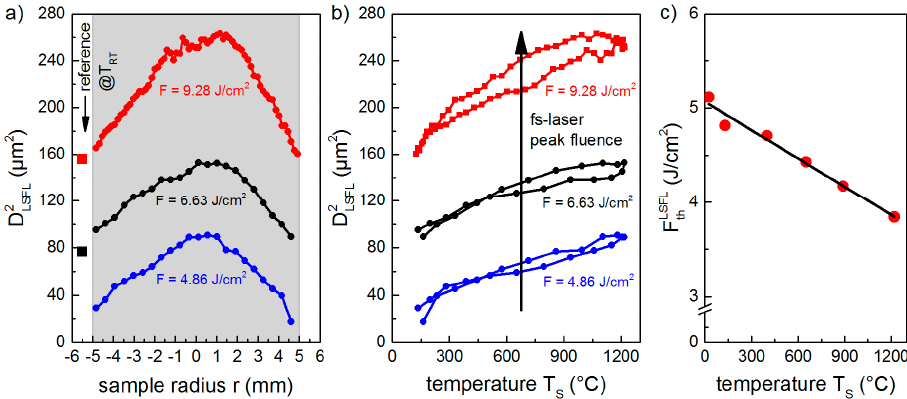
Figure 5. Evaluation of the area covered with LSFL (diameter D LSFL ): ( a ) D 2LSFL in dependence on the sample radius, r , ( b ) D 2LSFL in dependence on the corresponding substrate temperature T S and ( c ) temperature-dependency of the threshold F thLSFL for the formation of LSFL. T RT indicates room temperature.